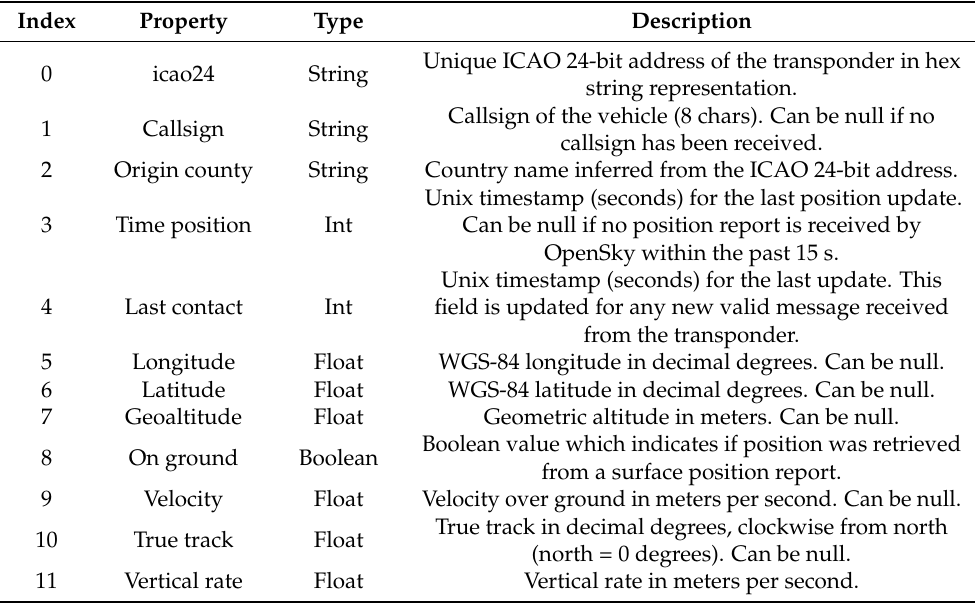
Table 4. OpenSky ADS-B JSON Object Definition [35].